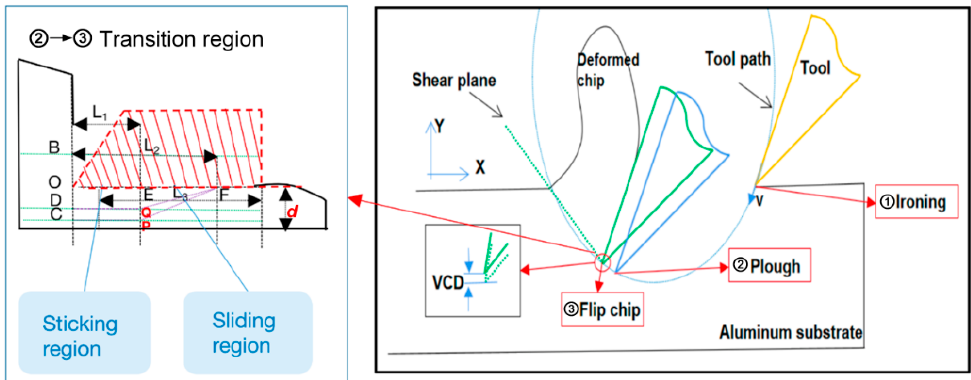
Figure 4. Friction mechanism of TMI in aluminum matrix.